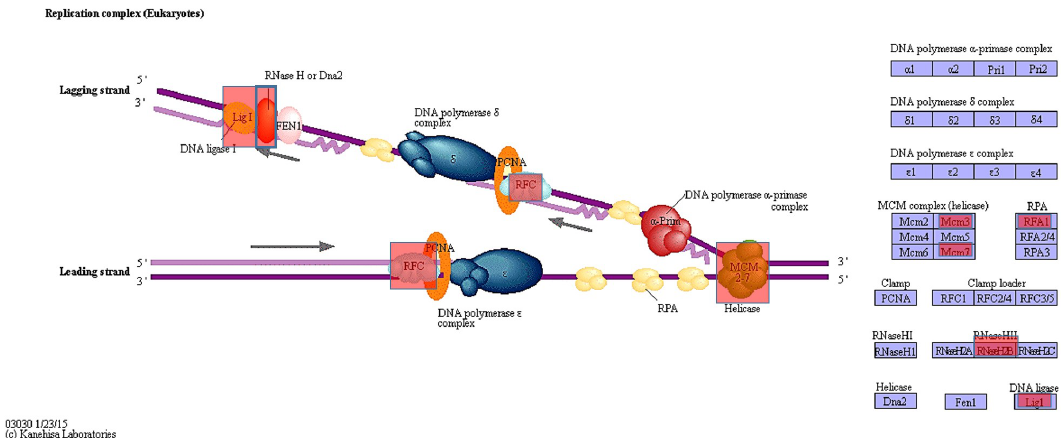
Figure 2. Polymerase-related genes identified using Kyoto Encyclopedia of Genes and Genomes (KEGG) pathway analysis. DNA replication of genes related to protein functions and genes related to transcription are shown. Circles indicate genes with amino acid changes. We did not observe any amino acid changes or gene mutations in topoisomerase genes. However, it is possible that common mutations were removed in MOLT-3/IDR and MOLT-3 cells. Adapted from